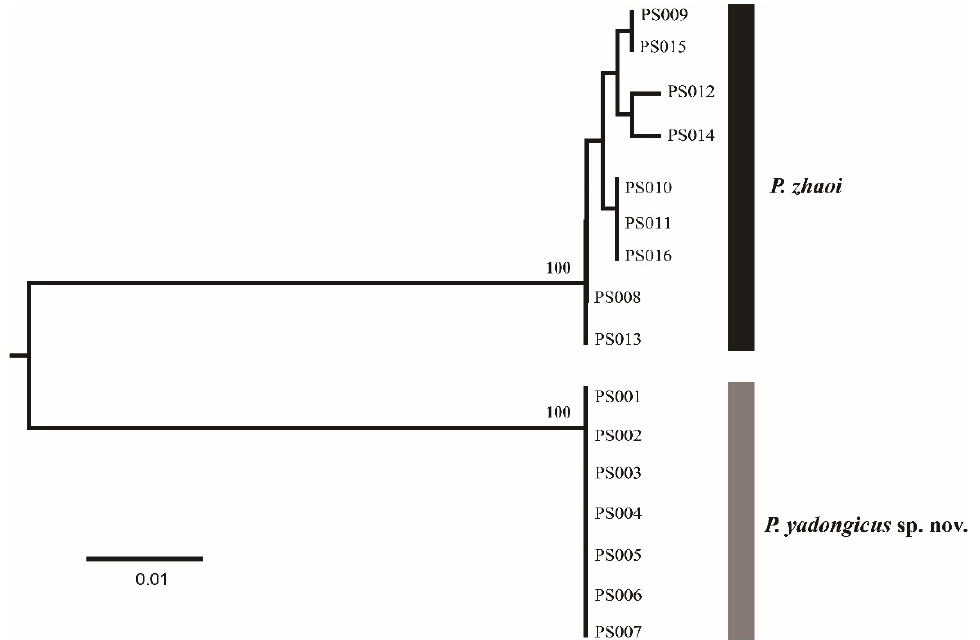
Figure 1. A NJ tree by K2P distances based on COI sequences from 16 Pseudanaphes specimens. The numbers above nodes indicate bootstrap values.